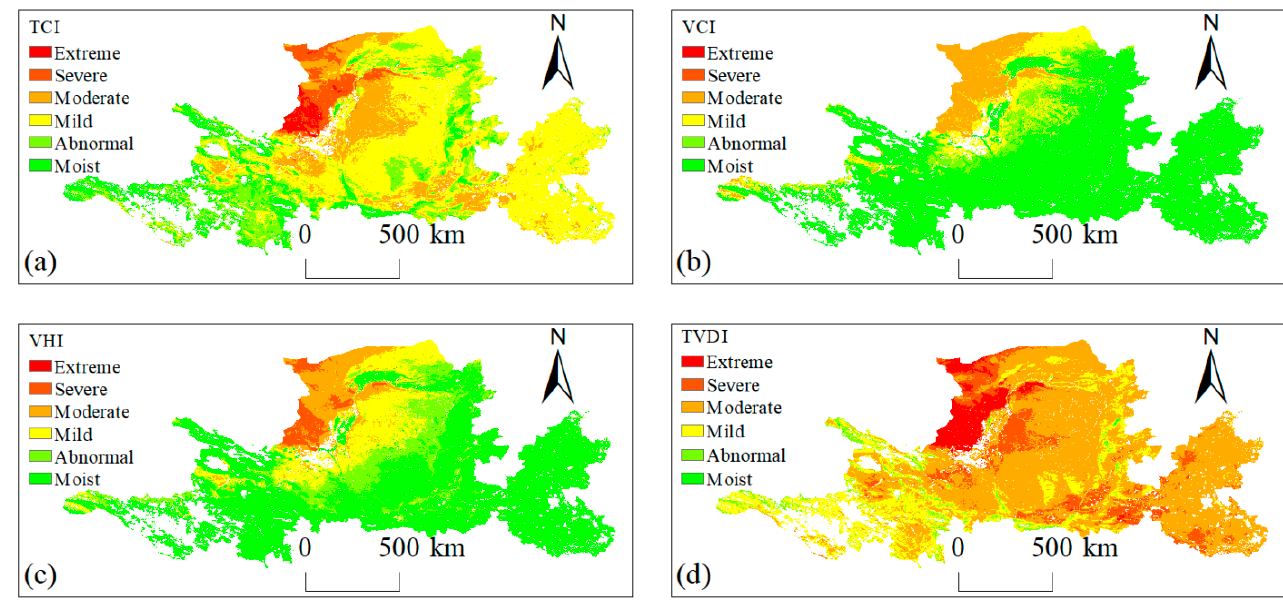
Figure 6. Average of drought index during the period 2003–2019. ( a ) TCI; ( b ) VCI; ( c ) VHI; ( d ) TVDI.